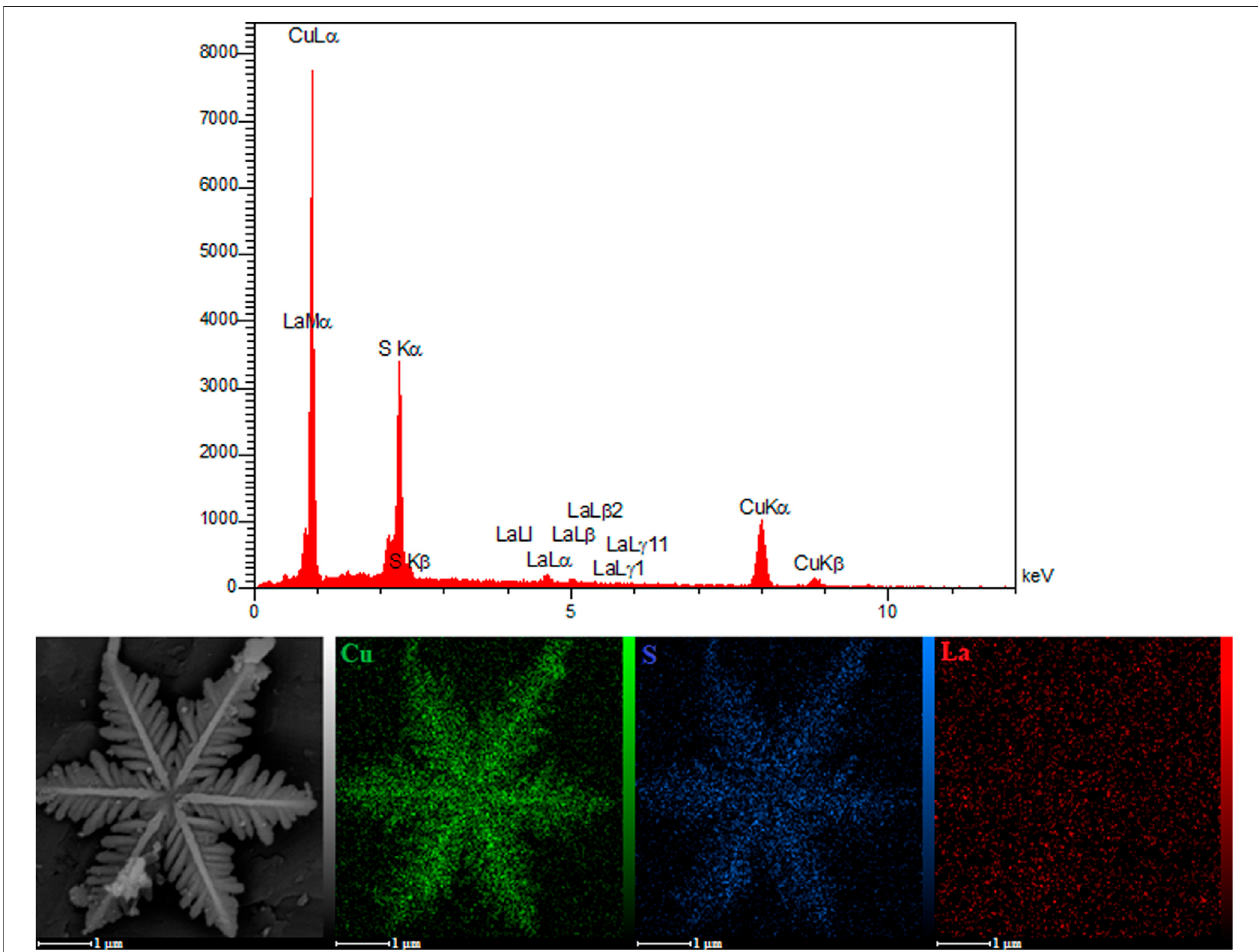
FIGURE 3 | EDX spectra and elemental mapping of the La 2 O 3 NP@SF-L Cu 2 S NS composite.